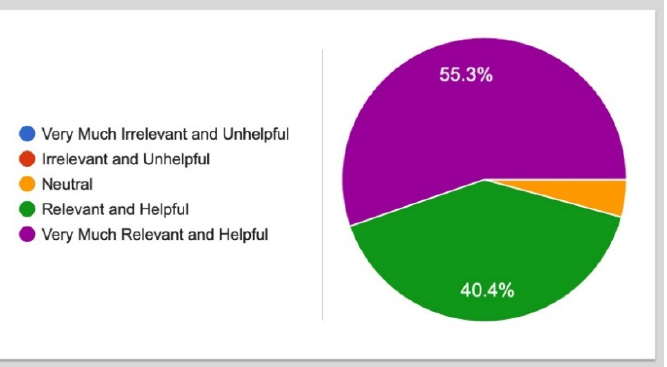
Figure 7. Willingness of students to join other similar event.